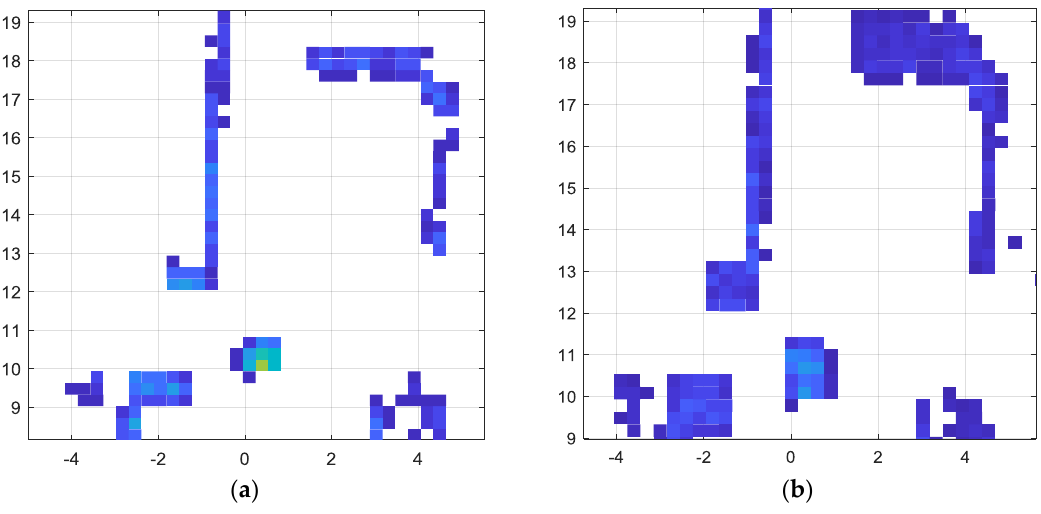
Figure 13. The effect of temporal window width for LiDAR frame accumulation. As the temporal window width is changed from 1s to 2s, the spread of values increases. ( a ) When temporal window width is 1s; ( b ) when temporal window width is 2s.